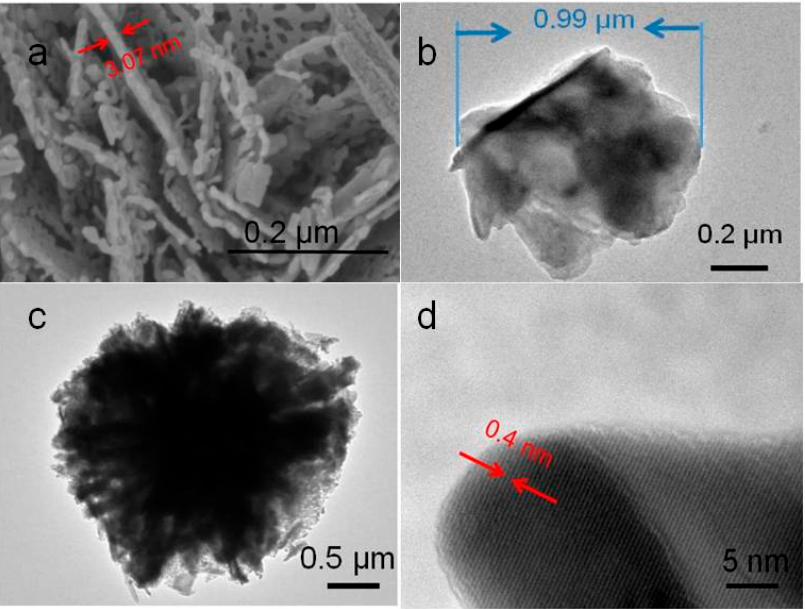
Figure 5. ( a ) High resolution SEM and ( b – d ) transmission electron microscopy (TEM) images of In 2 O 3 ‐ 8 h.